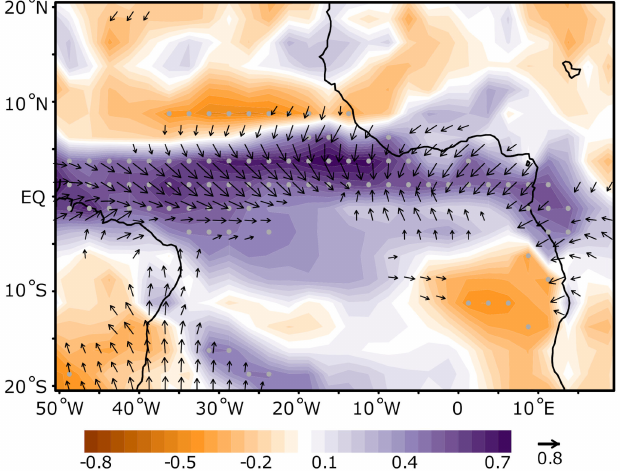
Figure 6. Correlation map between PC1 score and precipitation (color, GPCP, 1979–2015) and wind stress (vector, ERA-Interim, 1979–2011) in June. The gray dots denote 95% significance